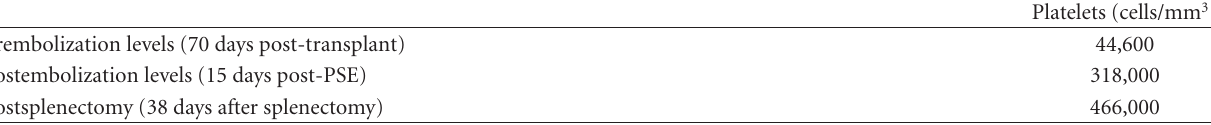
Table 1: The evolution of blood platelet levels.